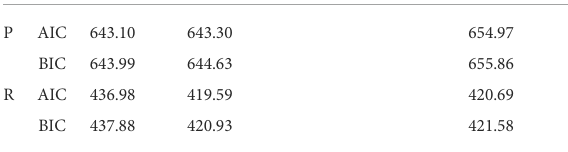
TABLE 2 Distribution function fi tting effect